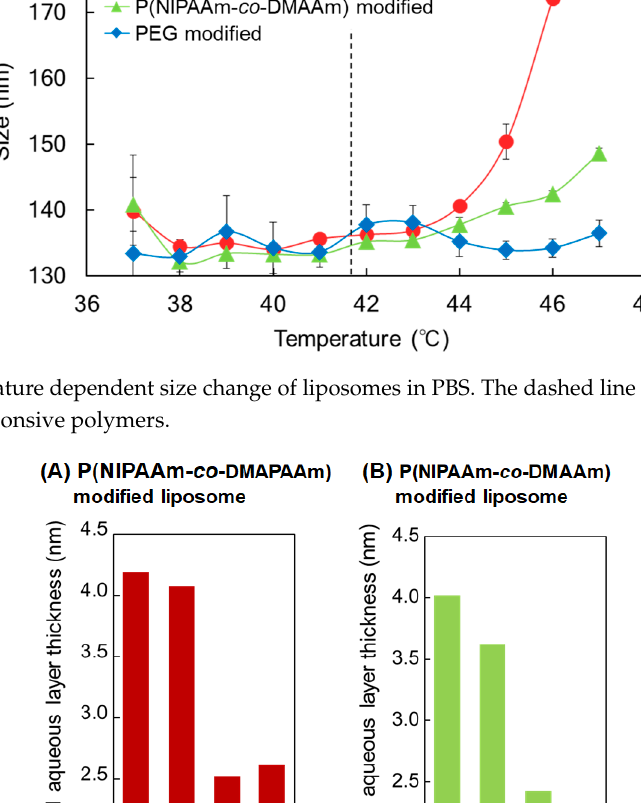
6 of 18 Figure 3. Stability of liposomes in serum for 24 h at 37 °C. Monitoring wavelength: 450 nm. Serum concentration: 50 v / v %. The temperature-dependent size change of the liposomes was observed using PBS as the suspension solvent (Figure 4). PEG modified liposomes maintained their size as the temperature was increased. In contrast, P(NIPAAm- co -DMAPAAm) and P(NIPAAm- co -DMAAm) modified liposomes exhibited an increase in size above the LCST of the polymers. At lower temperature, P(NIPAAm- co -DMAPAAm) and P(NIPAAm- co -DMAAm) were hydrated and extended, leading to the formation of an aqueous outer liposome layer, which prevented the aggregation of the liposomes. Above the LCST, the polymers became hydrophobic, which is attributed to dehydration, leading to a reduction in the aqueous layer of the liposomes. The reduced aqueous layer induced aggregation of the liposomes, leading to an increase of the observed liposome size. In addition, above the LCST of the polymers, P(NIPAAm- co -DMAPAAm) modified liposomes exhibited a clear increase in size